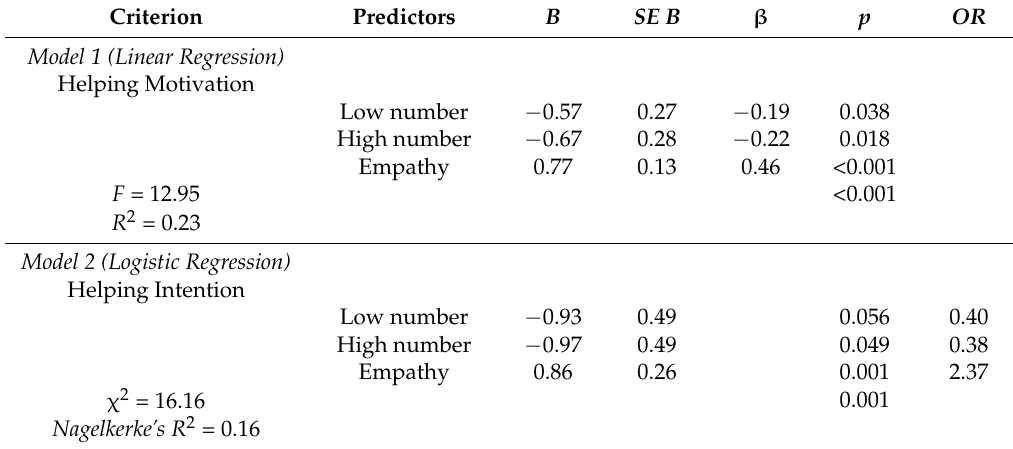
Table 1. Regression coefficients of the main analyses ( n =